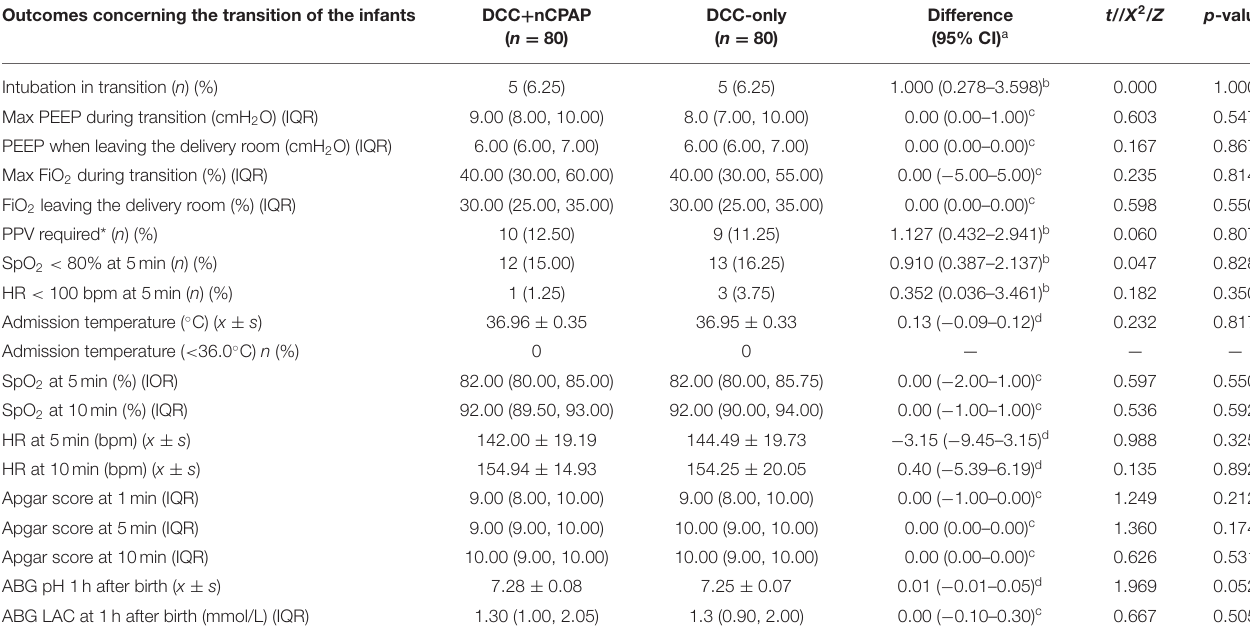
TABLE 2 | Outcomes concerning the transition of the infants. Outcomes concerning the transition of the